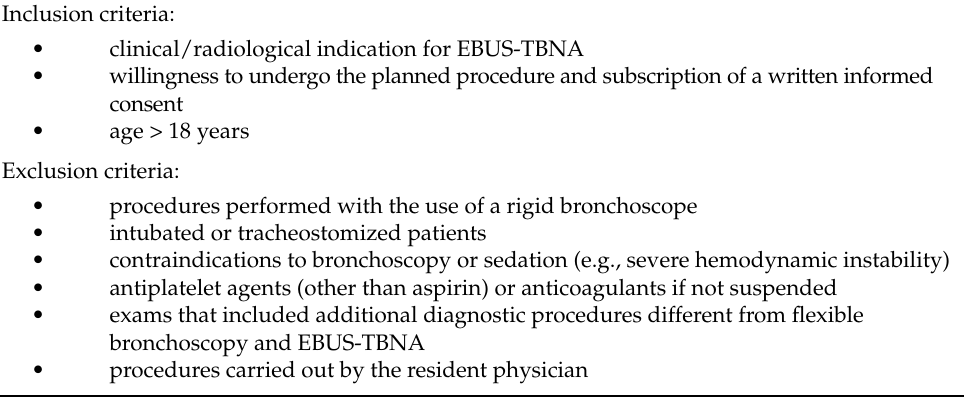
Table 1. Inclusion and exclusion criteria for EBUS-TBNA, the endobronchial ultrasound-guided transbronchial needle